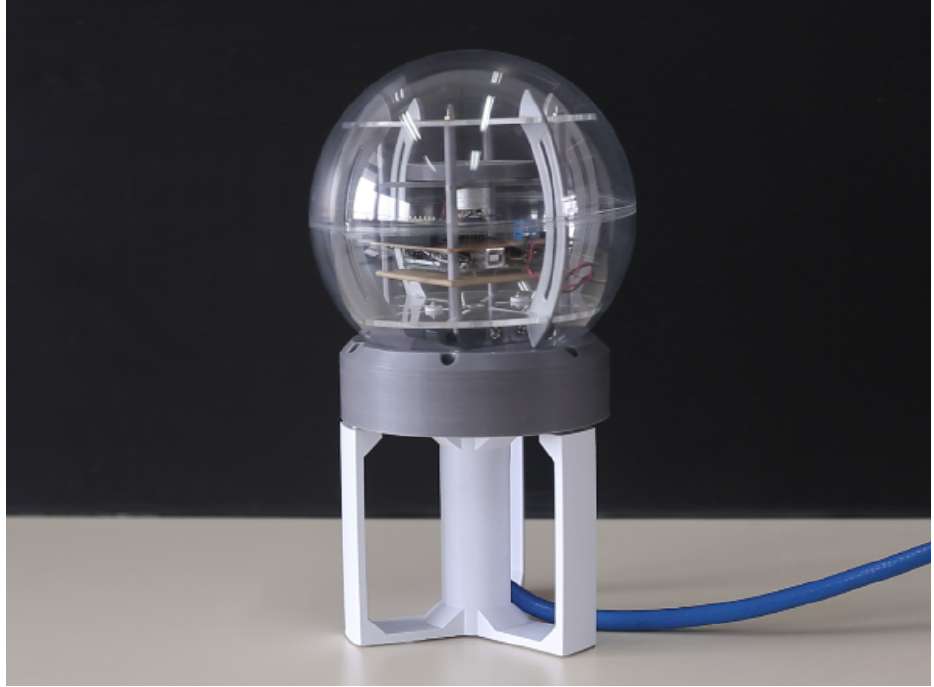
Figure 8. Photograph of the ADCS model used for experimental verification of the presented attitude estimation algorithm based on gradient descent and complementary